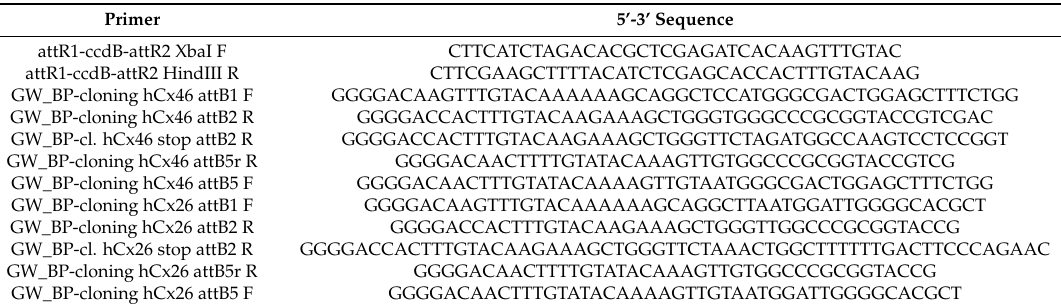
Table 4. Primers used for restriction enzyme cloning to produce the destination vector psGEMHE-GW and for the BP-cloning to generate the various Entry